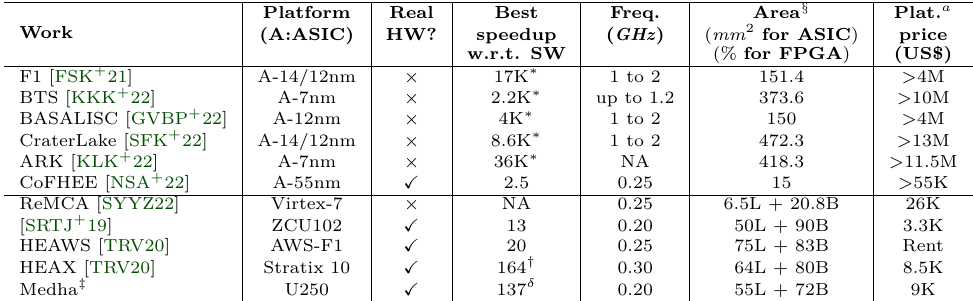
Table 5: Comparison of Hardware Accelerators for Homomorphic